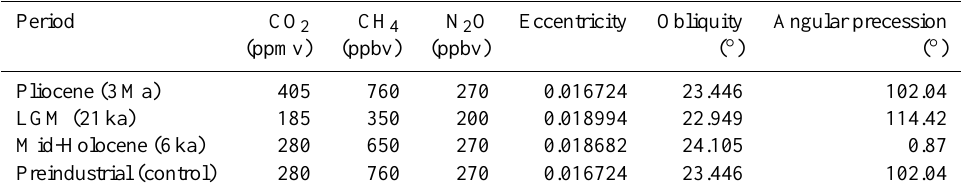
Table 1. Trace gases and Earth’s orbital parameters recommended for PMIP. The precession is specified with respect to Northern Hemispher autumnal